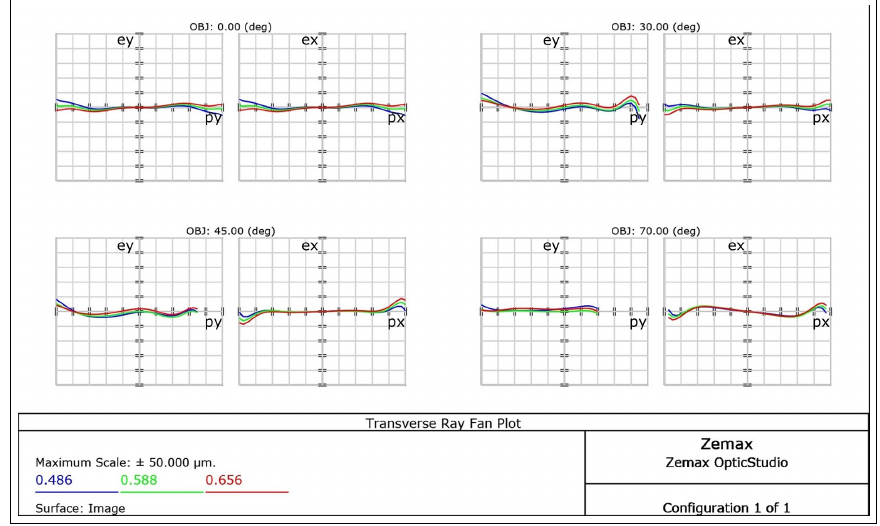
Figure 3. Ray fan plot of the optimized system.